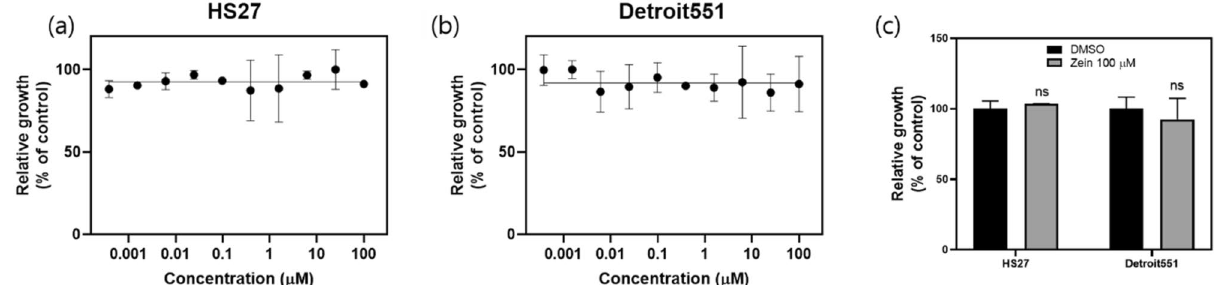
Figure 2. Biocompatibility results for zein and anti-proliferative abilities of zein organics for normal ( a ) HS27 and ( b ) Detroit551 skin cells. Note that the CellTiter-Glo assay demonstrated up to a 100-μM concentration of zein after 72 h of cell growth. ( c ) The relative growth results for normal HS27 and Detroit551 skin cells in the DMSO solvent and in zein at a 100-μM concentration after 72 (fibroblast, male) and Detroit 551 (fibroblast, female) skin cells. For the dose-dependent effect, the concentration of zein in dimethyl sulfoxide (DMSO) was adjusted from 0.001 to 100 μM, and for the time-dependent effect,